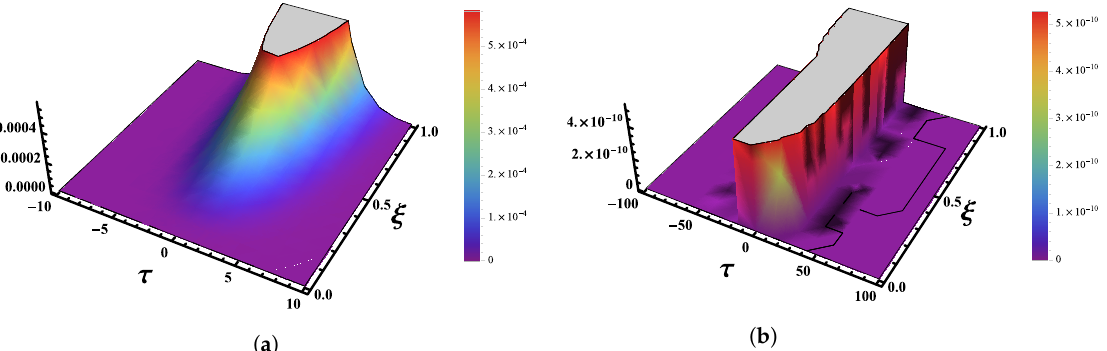
Figure 5. Absolute Error (AE) 3D graph of obtained numerical solutions using FNAM